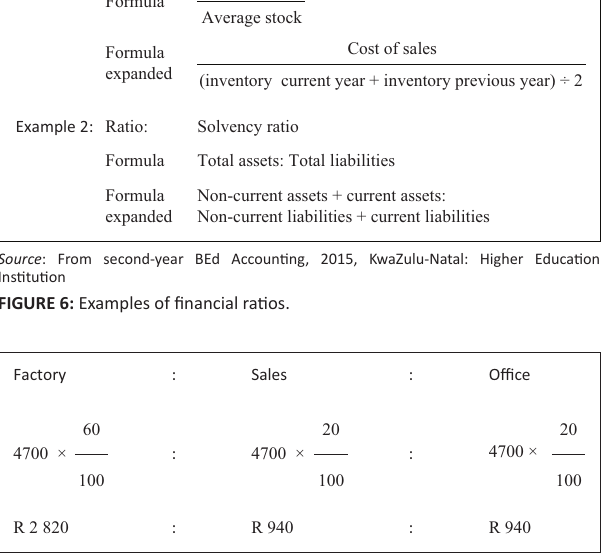
FIGURE 7: Allocation of amount according to given percentages.